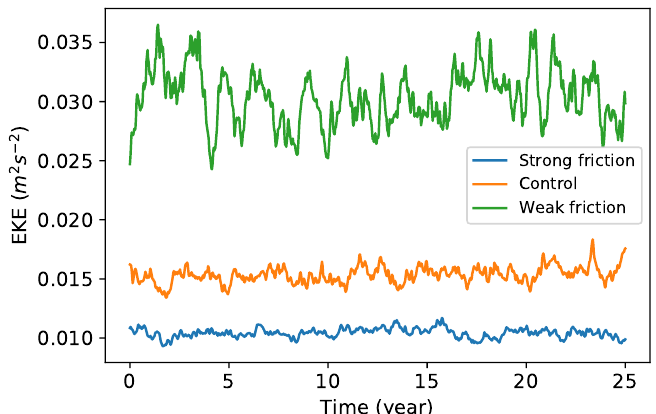
Figure 1. Time series of upper layer eddy kinetic energy (EKE) of the three simulations. Blue, orange, and green curves indicate the weak friction, control, and strong friction cases,